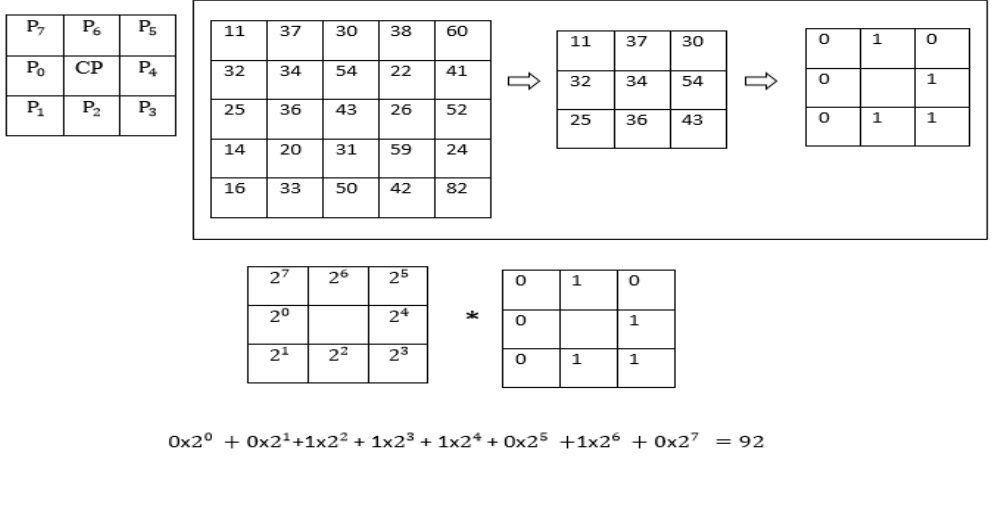
Figure 2 . Calculation of Local Binary Pattern for every